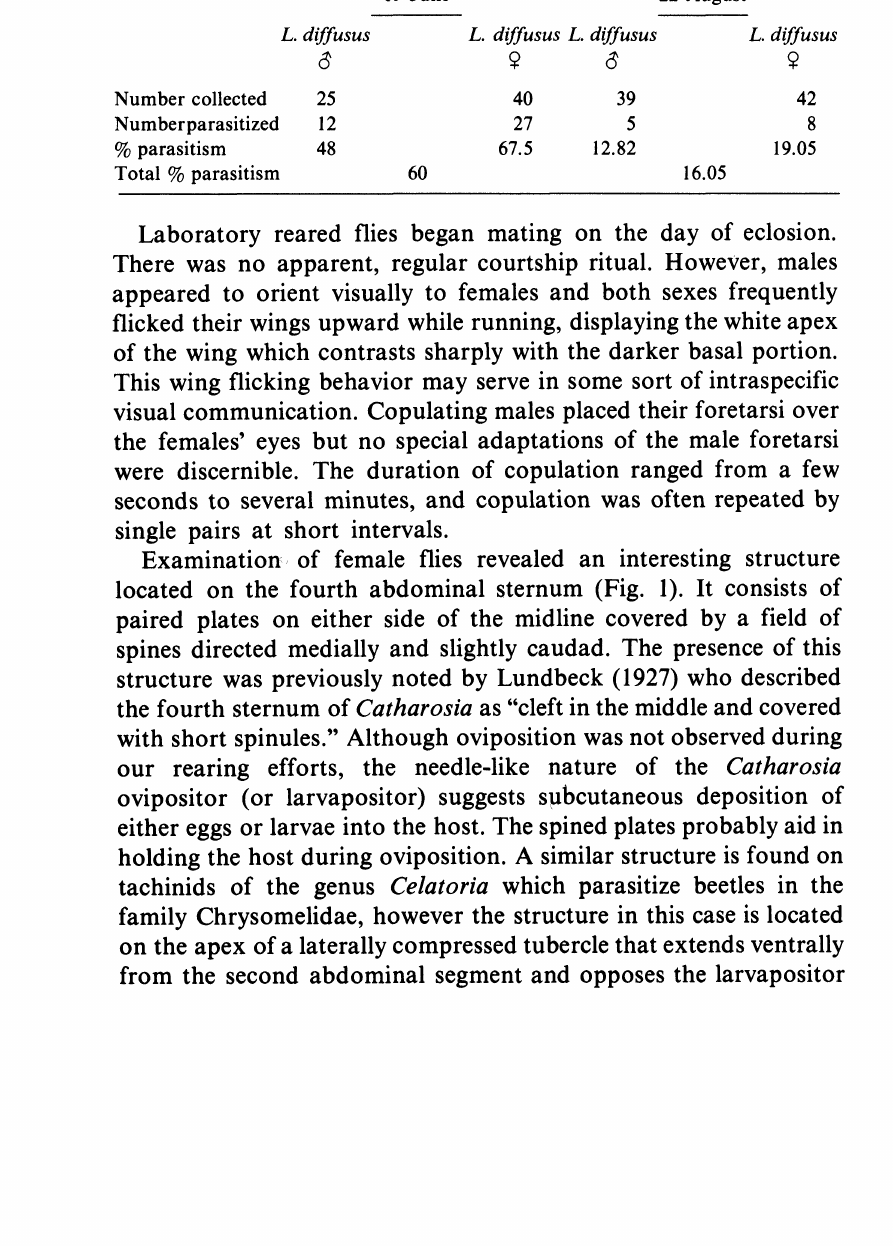
Table 1. Rates of parasitism by Catharosia in L. diffusus collected on 2 separate dates in 1978 in Wood Co.,